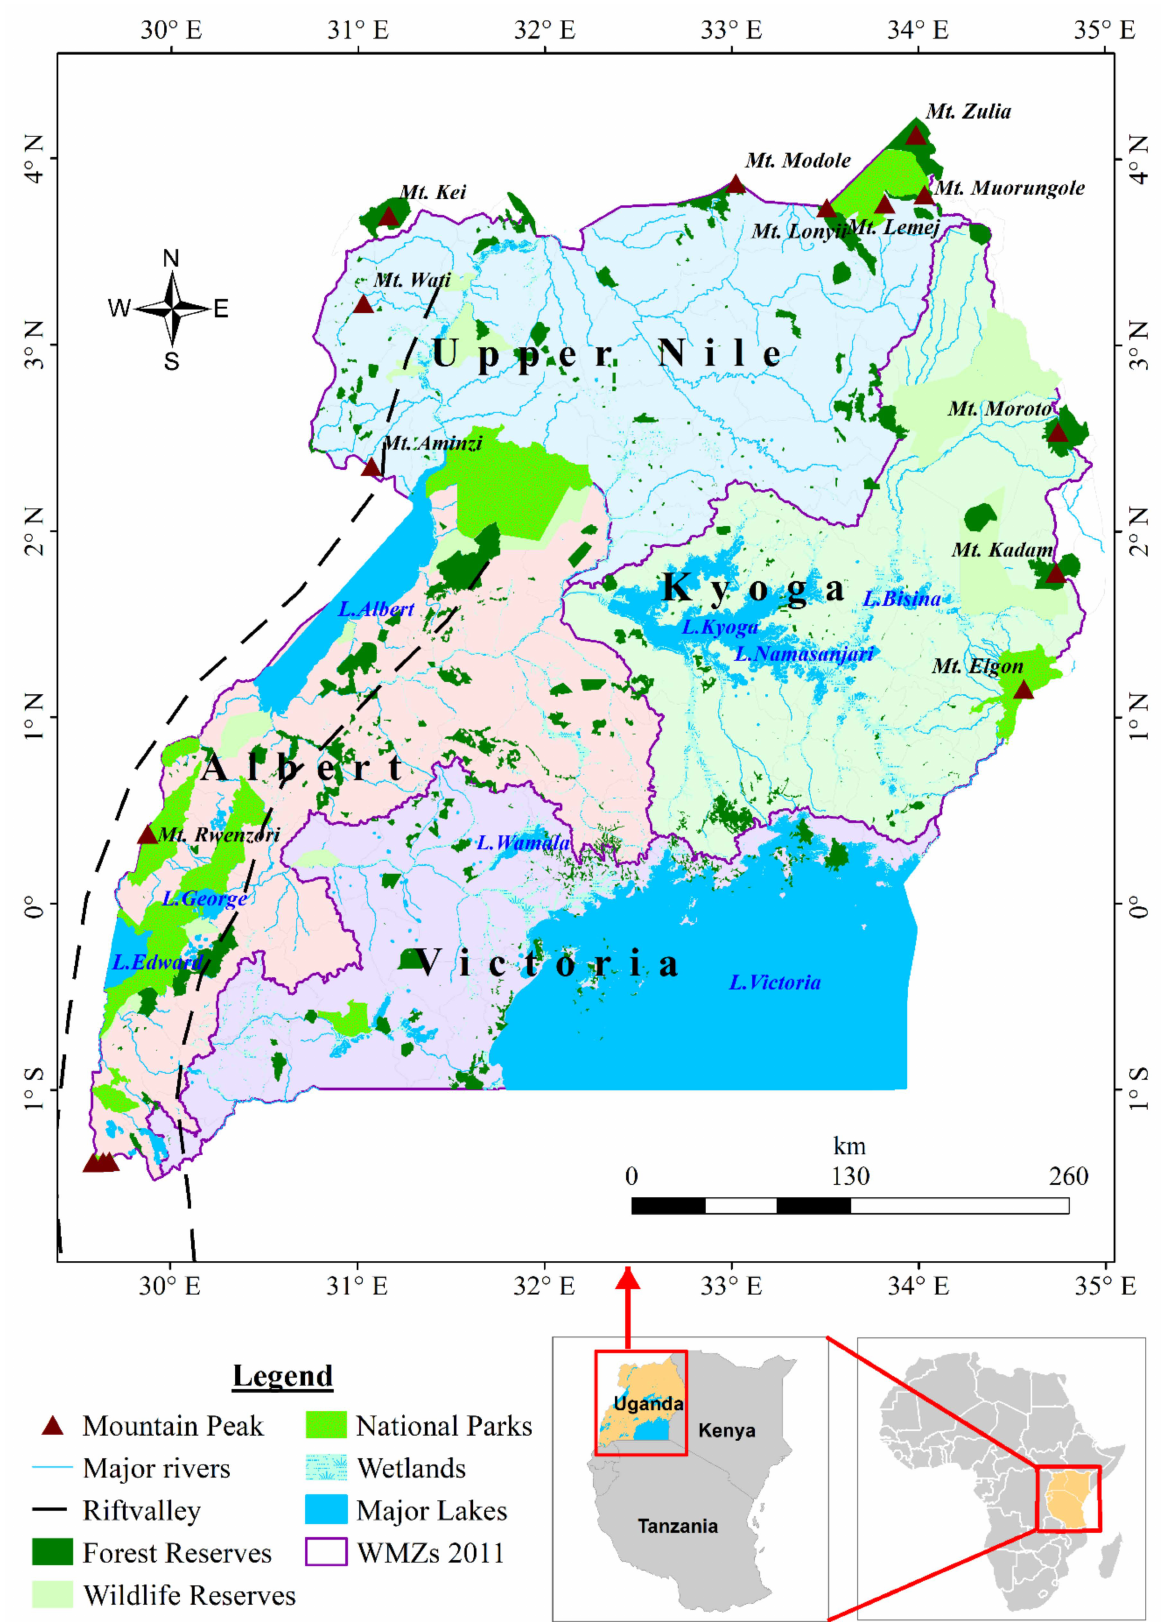
Figure 1. Uganda’s WMZs and some physical features including lakes, rivers, rift valley, wetlands, and